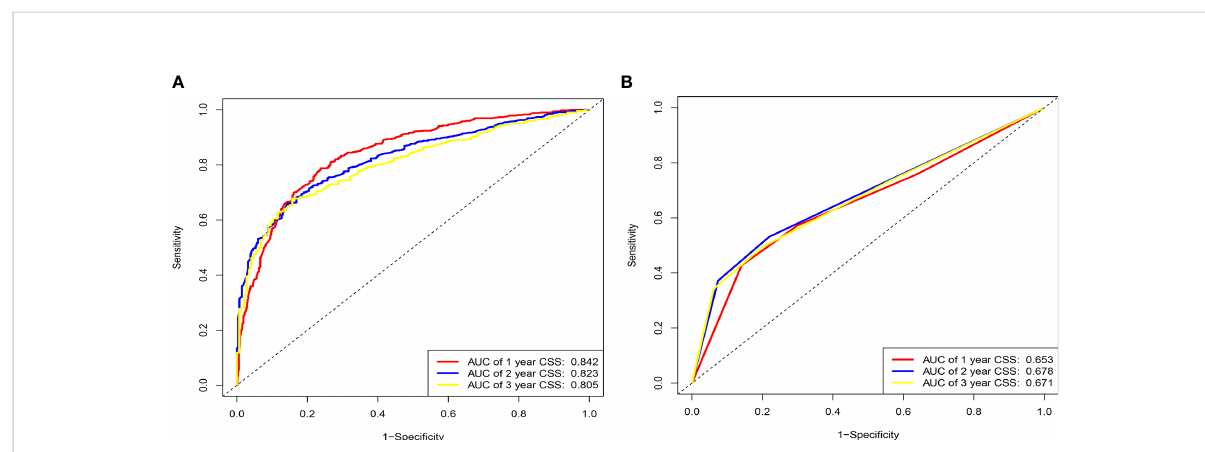
FIGURE 3 ROC curves for the AJCC staging and nomogram for 1-, 2-, and 3-year prediction. (A) Training cohorts based on the nomogram. (B) Validation cohorts based on AJCC